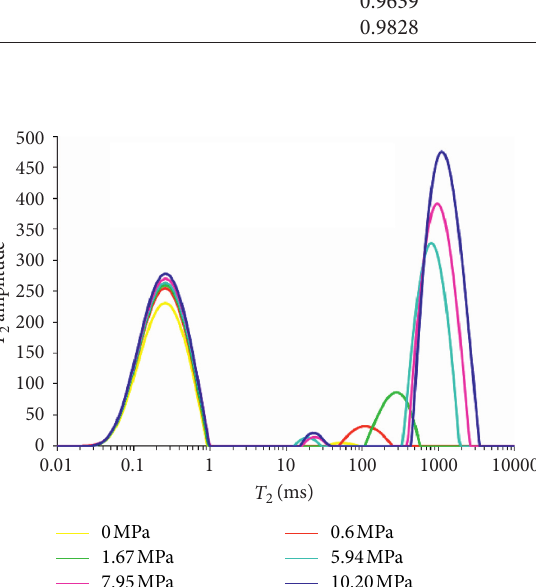
Figure 9: T 2 spectra of polymorphic methane under different pressures.